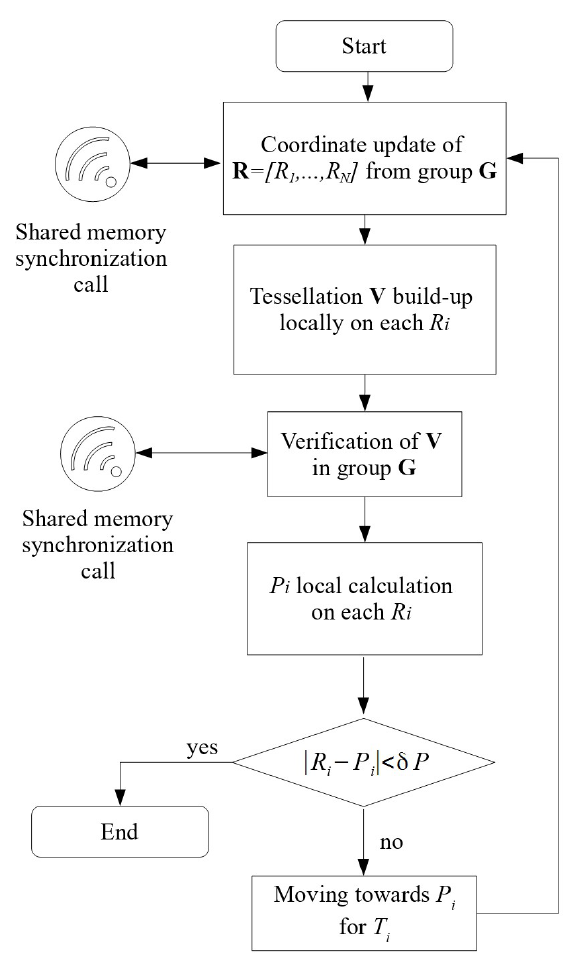
Figure 1: Voronoi multi-robot tessellation